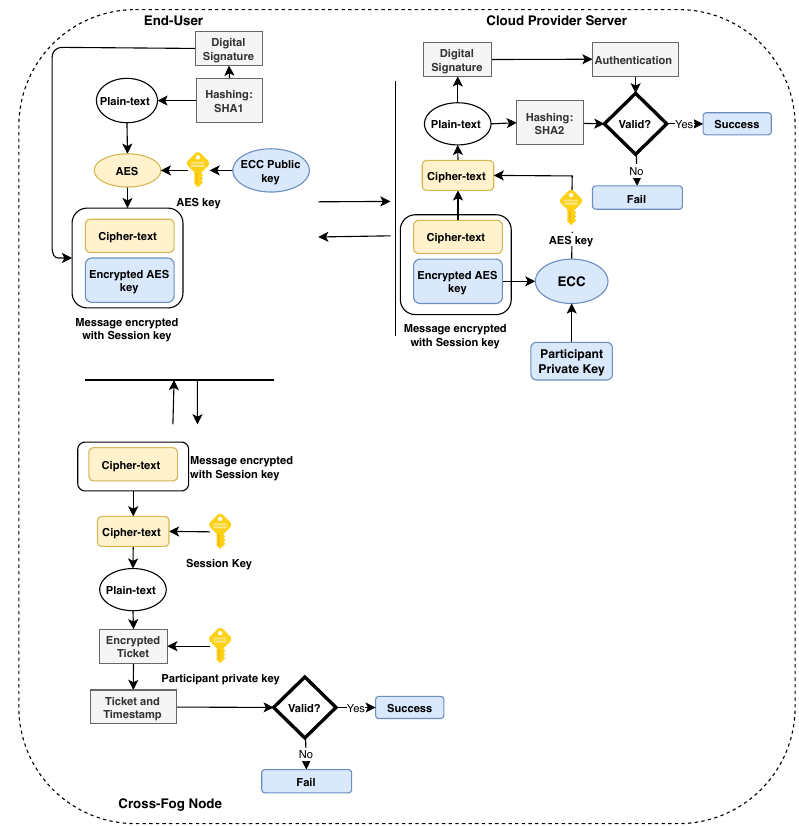
Figure 3. The system architecture for